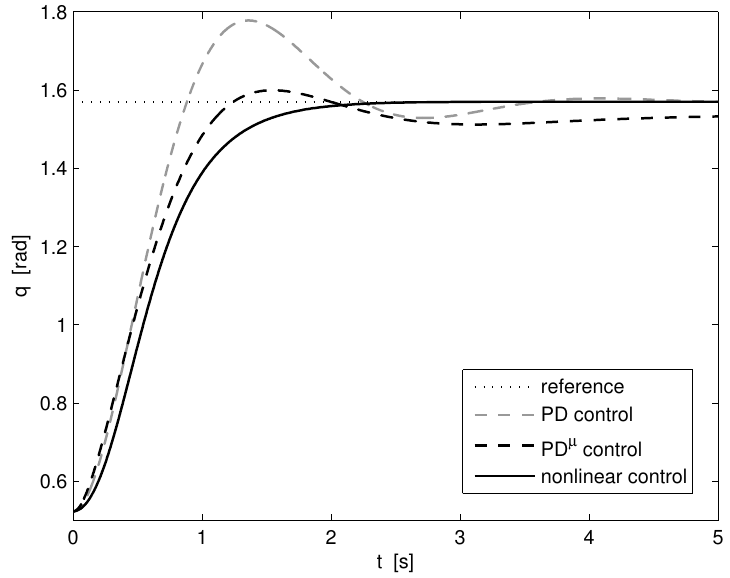
Figure 4. Angular position of the crank, comparison with PD and PD µ